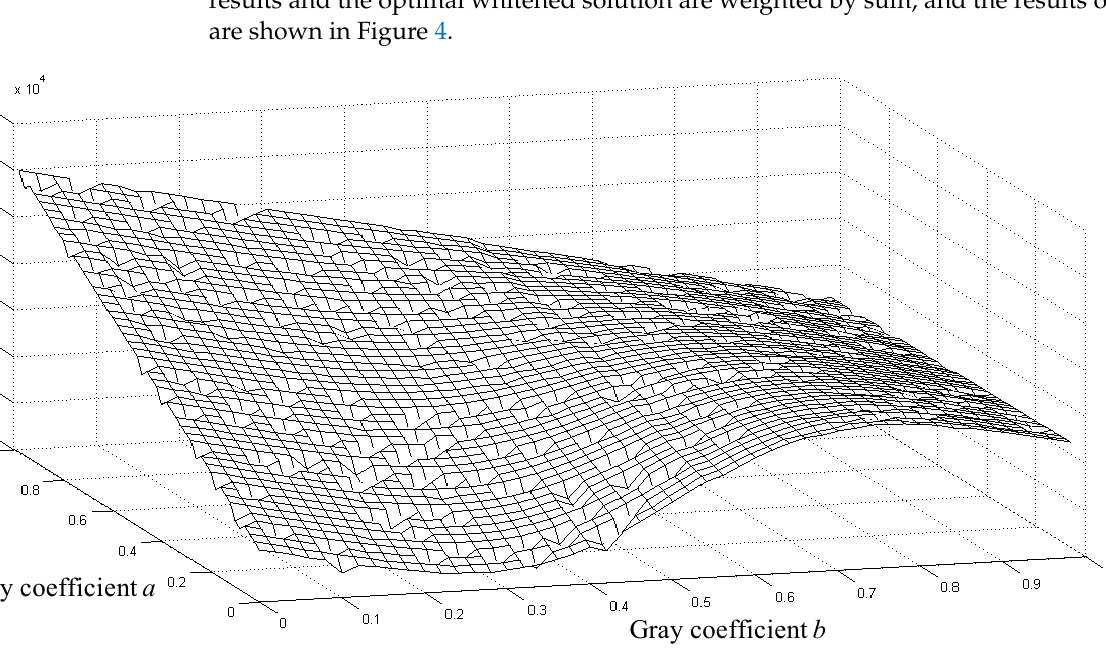
0 (cid:82) 50 (cid:82) µ ( i ) λ ( j ) didj . Then, the integral i j